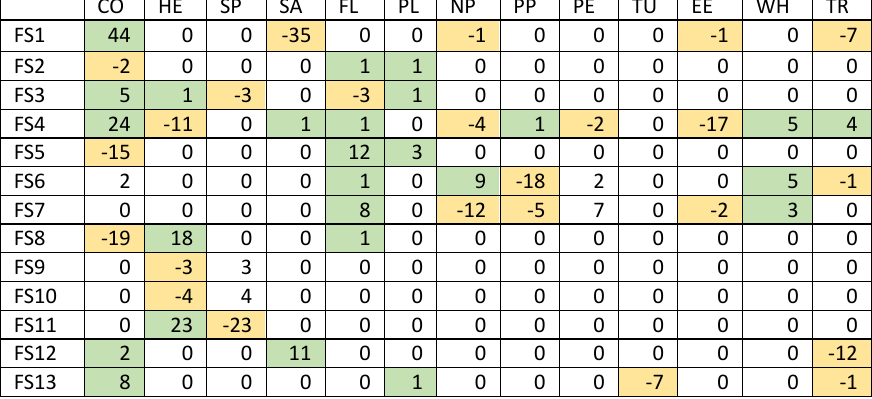
Table A6. Potential changes in the relative pressure on fish species as change between the years 1996 and 2009 in percentage points. The numbers are calculated for an average fisher per fishing strategy. Green colour is used to mark the increase in fishing pressure from 1996 to 2009, and yellow marks decrease. This table is based on the data same data as Tables S1a and S1b. The table aids to comprehend differences in Figure S1 link